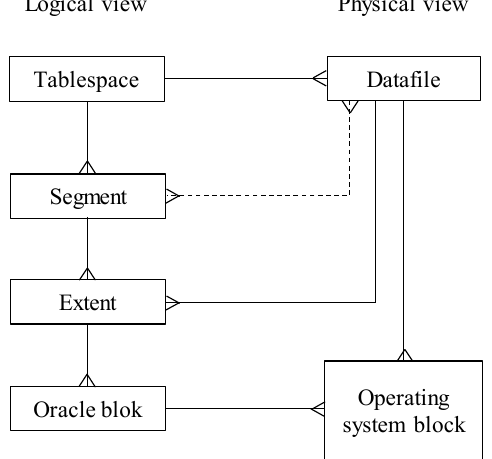
Figure 16. Database storage model.